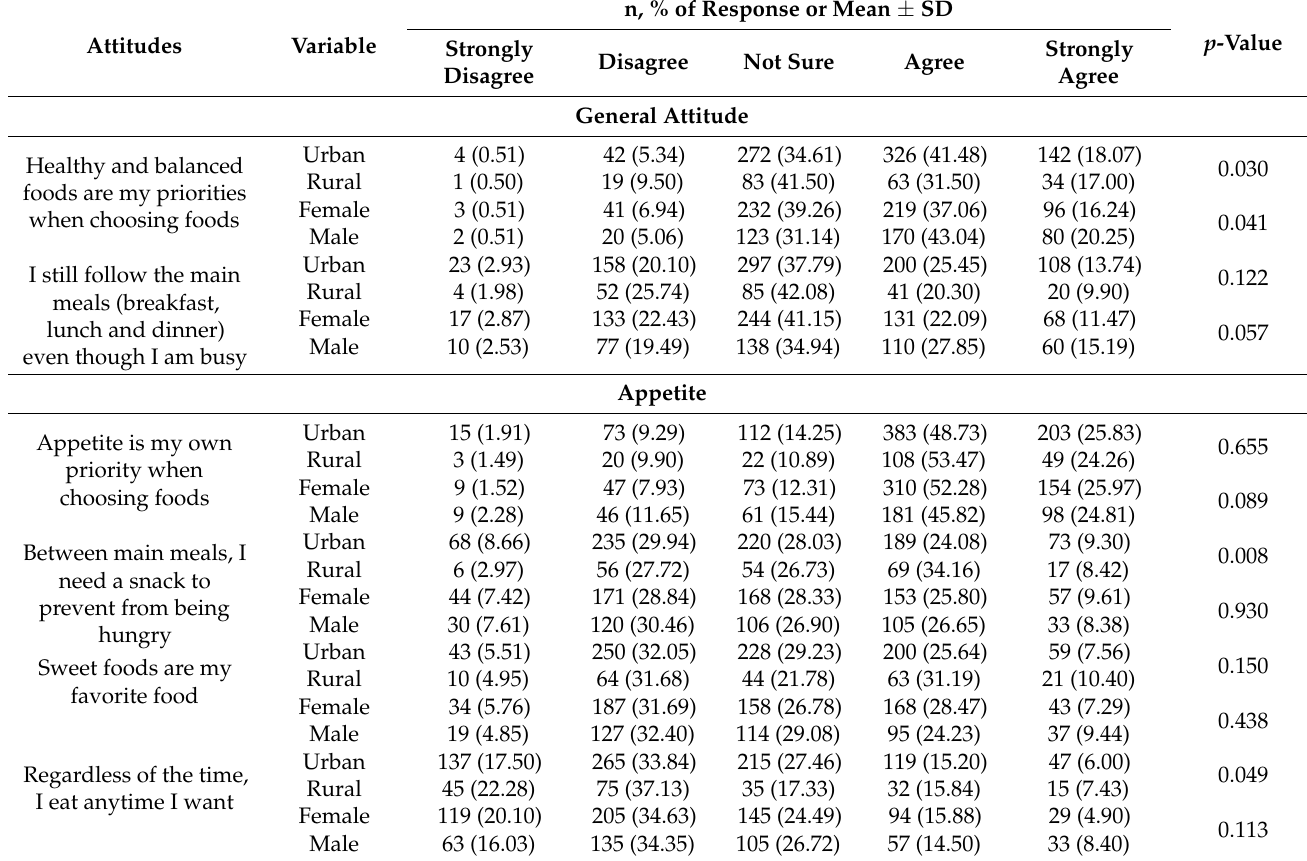
Table 3. Nutritional attitudes and their association with locality of schools and gender and